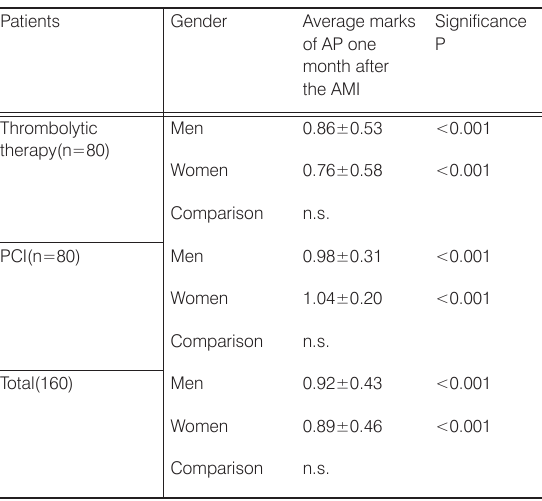
Table 5. The average marks of angina pectoris at the admis- sion in intensive care unit and one month after the AMI